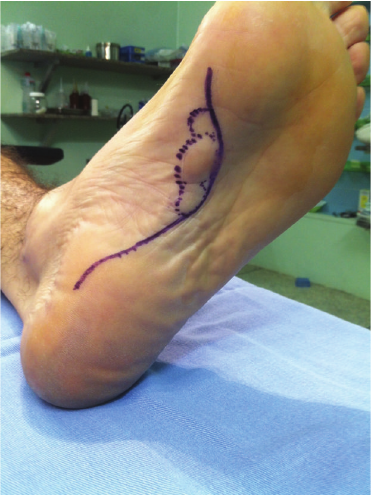
Figure 3: Detailed view of the three palpable